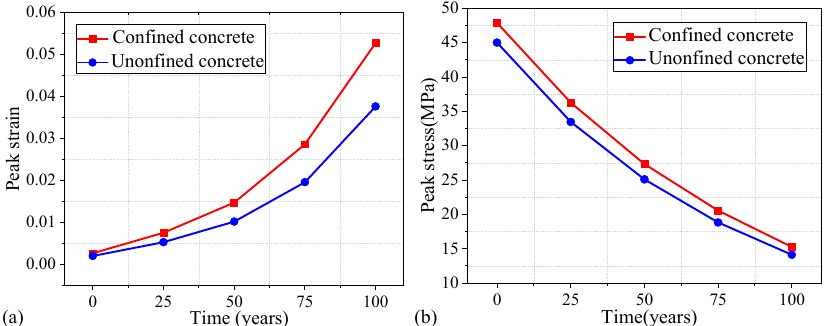
Figure 11. Time-dependent material properties of the confined and unconfined concrete: ( a ) the peak strain and ( b ) the peak stress.